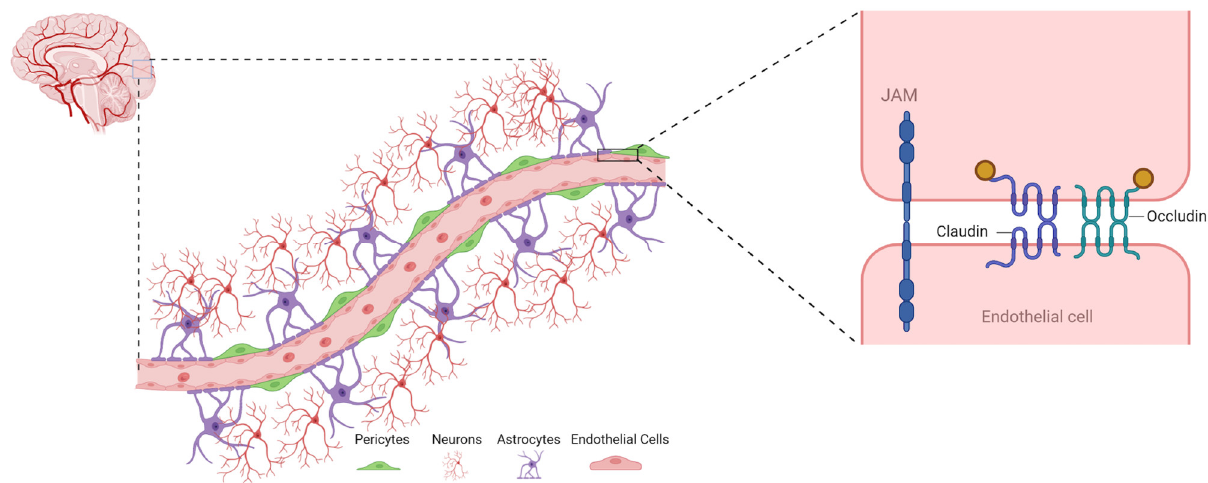
Figure 1. Schematic representation of structural components of the blood–brain barrier (BBB) and junction protein in endothelial cells. The endothelial cells on brain capillaries are ensheathed by foot process of astrocytes and closely associated with pericytes, which together form a neurovascular unit. Structural components in endothelial cells responsible for barrier integrity are shown on the right, i.e., claudin, occludin, and JAM (Created with BioRender.com).